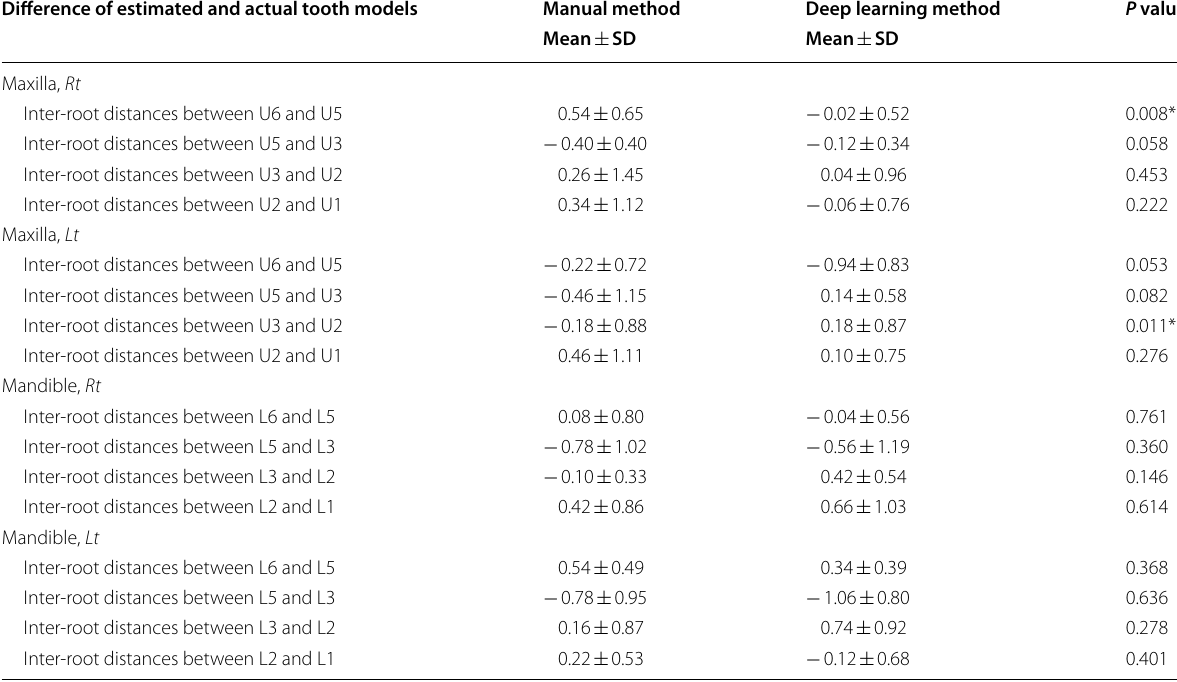
Table 9 Comparison of the difference of estimated and actual tooth models in inter‑root distance between manual and deep learning methods (unit: mm)